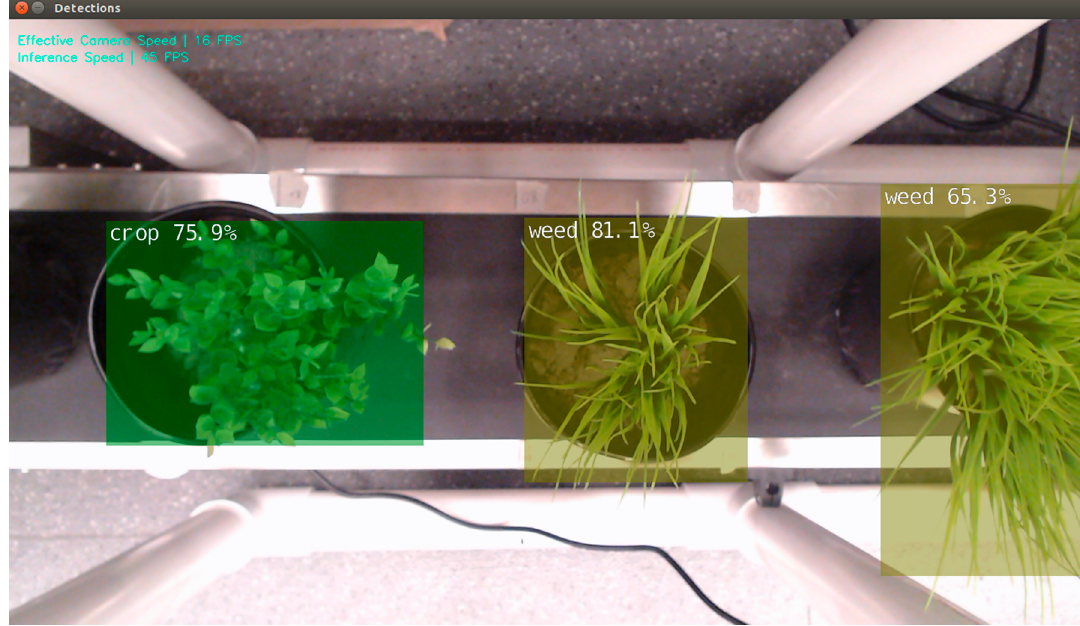
Figure 13. Sample real-time inferencing using trained SSD MobileNetV2 model and optimized in TensorRT. The vision system utilized Jetson Inference API. Table 6. Theoretical and simulation performance of the CNN-based vision module for plant detection (cid:42) v at S = 0.79 m, 16 f ps , and at three-levels of travel velocity (